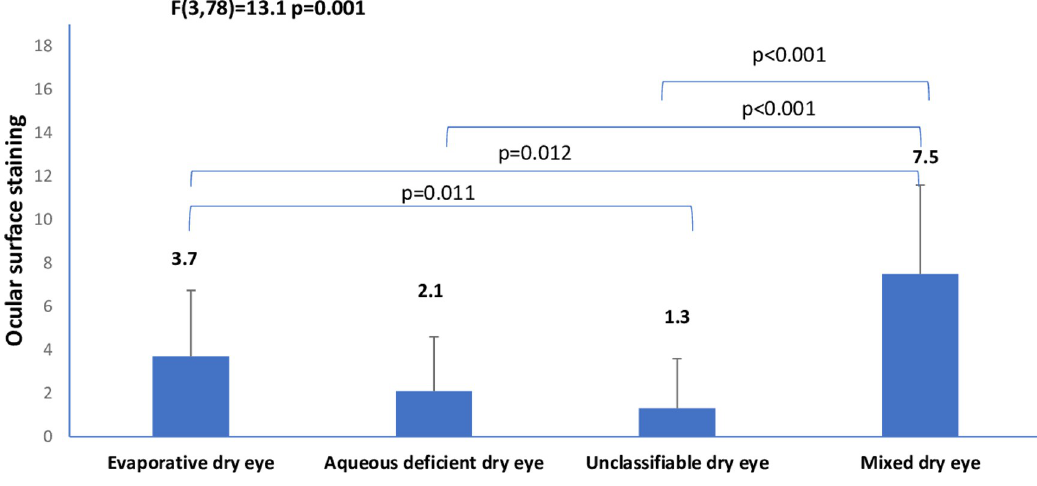
Fig 2. Means of ocular surface staining across clinical subtypes of dry